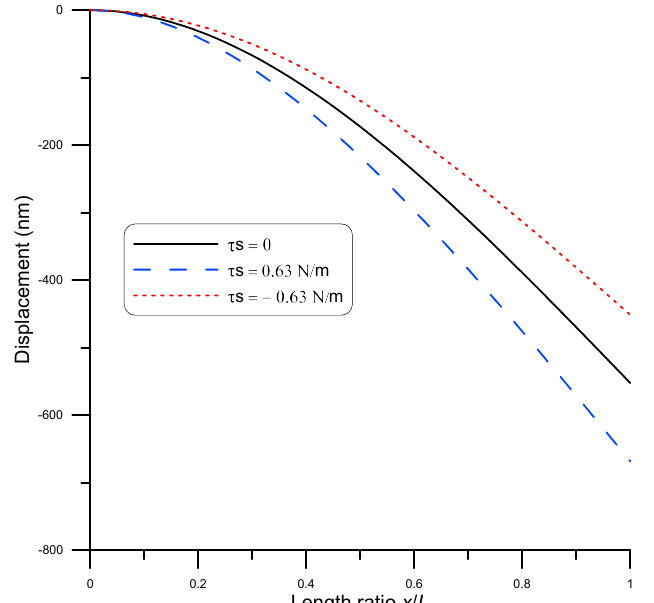
Figure 11. Nanobeam displacement under 1.4 nN point load at beam tip for the cases of τ s = 0 (solid line), τ s = 0.63 N/m (blue dashed line), and τ s = − 0.63 N/m (red dotted